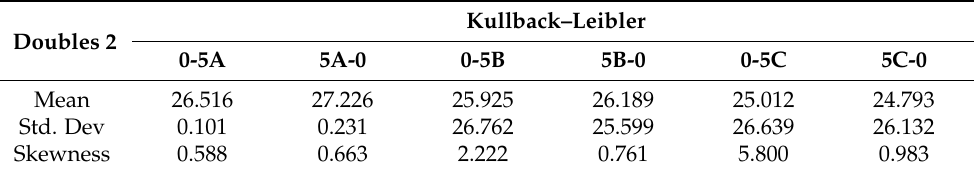
Figure 20. Comparison of the probability distributions obtained for the mean values of the doubles sensor 2 measurements in the case of failures associated with the doubles sensors. Indicators: ( top left ) mean, ( top right ) standard deviation, ( bottom ) skewness. Table 7. Kullback–Leibler divergence values associated with the means, standard deviations and asymmetries associated with the mean values of the double 1 sensor measurements for the identification of the failures associated with the double sensors.